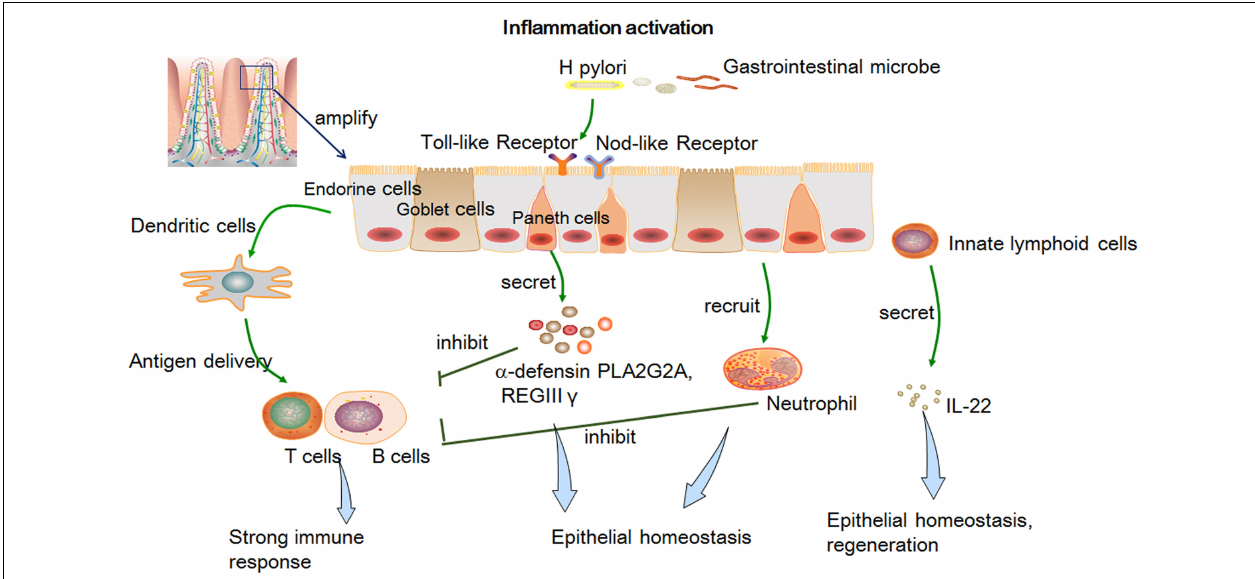
FIGURE 1 | The epithelial innate immune response and its effect on epithelial homeostasis, regeneration, inflammation, and gastric carcinogenesis after activation of inflammation by a pathogen. Epithelial cells can express pathogen recognition receptors to pass microbial signals (Nigro et al., 2014; Amieva and Peek, 2016) and generate various peptides against infection and prevent a strong T-cell-mediated immune response (Farin et al., 2014; Leslie et al., 2015); IEC-produced cytokines and dendritic cells can promote T-cell maturation and differentiation (Liu Y. et al., 2015); innate lymphoid cells can produce IL-22 and then regulate ISC survival and proliferation (Bermudez-Brito et al., 2013; Lindemans et al.,